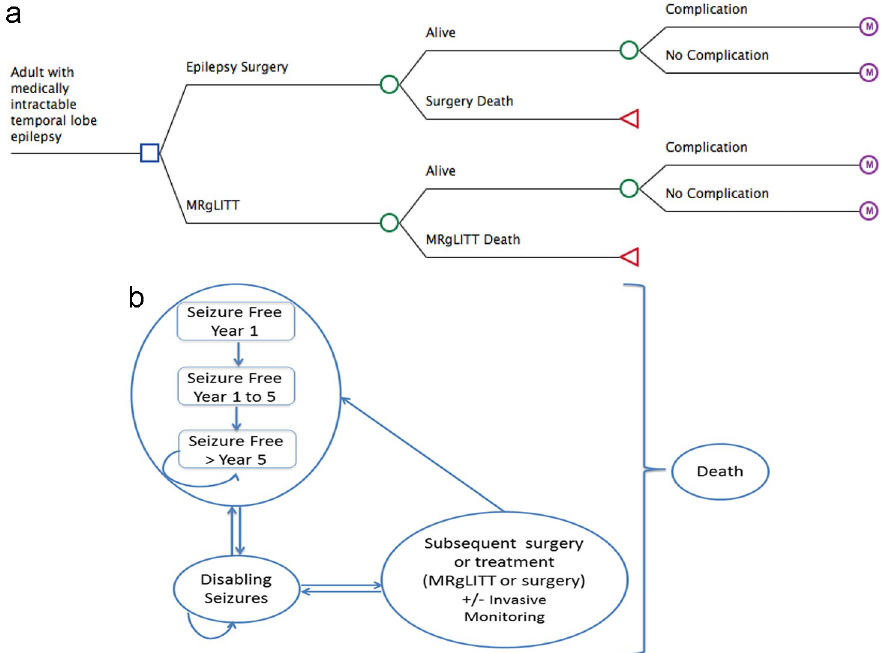
Fig 1. (a) Decision Tree and (b) health states for MRI-guided laser interstitial thermal therapy (MRgLITT) versus epilepsy surgery. disabling seizures annually the first 5 years after surgery [0.059 (95% CI: 0.009–0.110)] and more